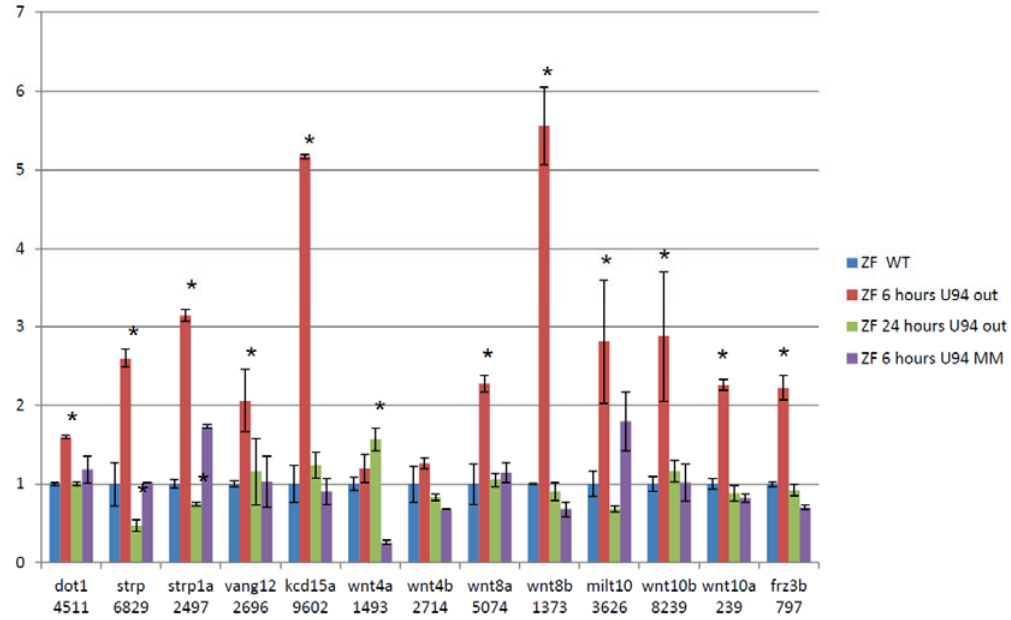
Figure 4. Treating zebrafish embryos with Anti-U94 morpholino causes changes in exon retention of cardiac regulatory genes. 13 of 39 members of the WNT family have changes in exon retention after treatment with antisense morpholino (assessed by RNA-Seq and qRT-PCR, Values shown are from qRT-PCR data). Data are fold change of exons that represents regions of variability within the alternatively spliced gene. (Each gene analyzed by qRT-PCR was done on 3 separate embryo samples with 3 technical replicates). * significant p <